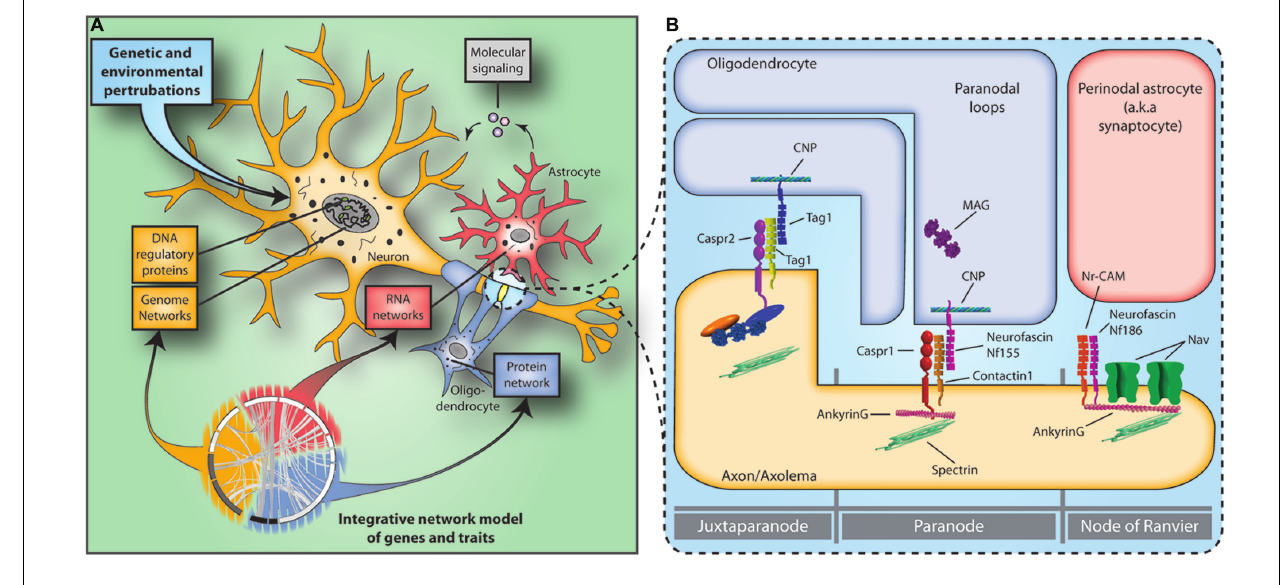
NOR is the site of intimate neuroglial cell–cell interactions in the nervous system. Abnormalities in the expression of NOR genes and proteins in schizophrenia hamper saltatory conduction by affecting NOR formation, maintenance and integrity and lead to the disconnectivity